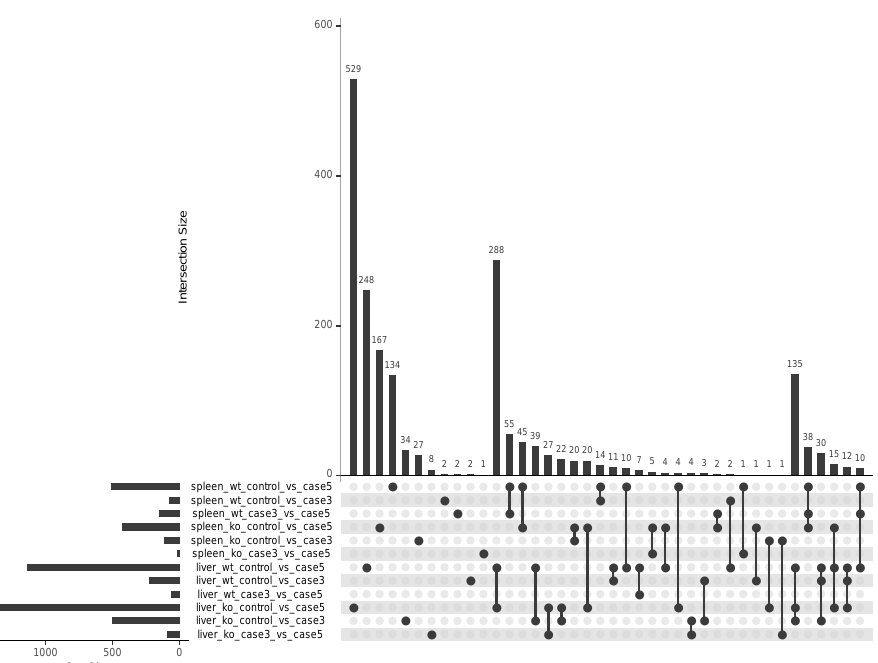
Figure A4. UpSet plot representing the commonalities between the 12 differentially-expressed genes (DEG) groups identified in differential expression analyses. The comparison of controls vs. samples at 5 d p.i. comprised the greatest number of genes for all sample